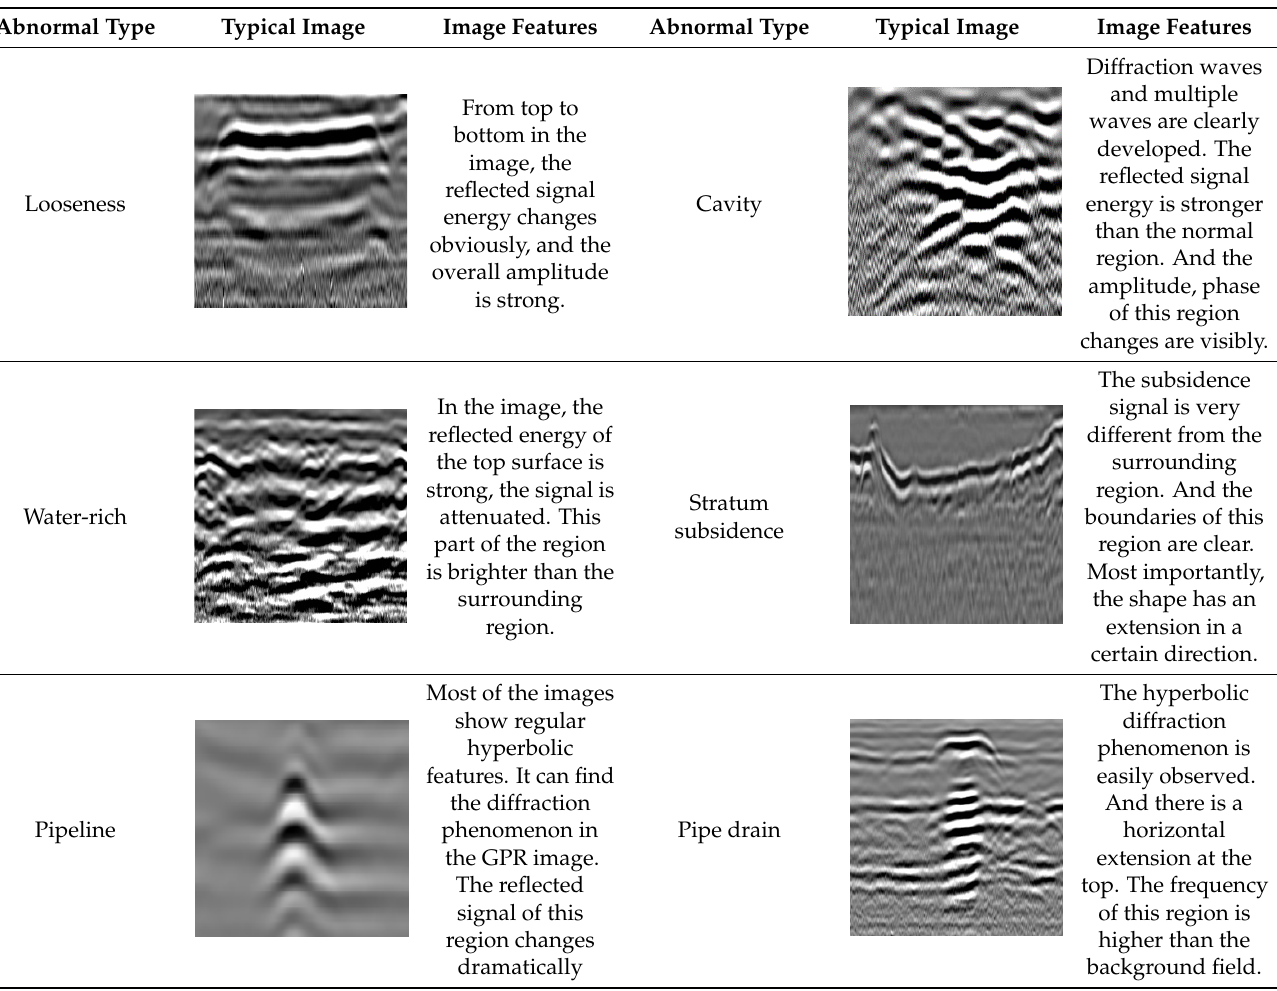
Table 1. Typical abnormal images and features.